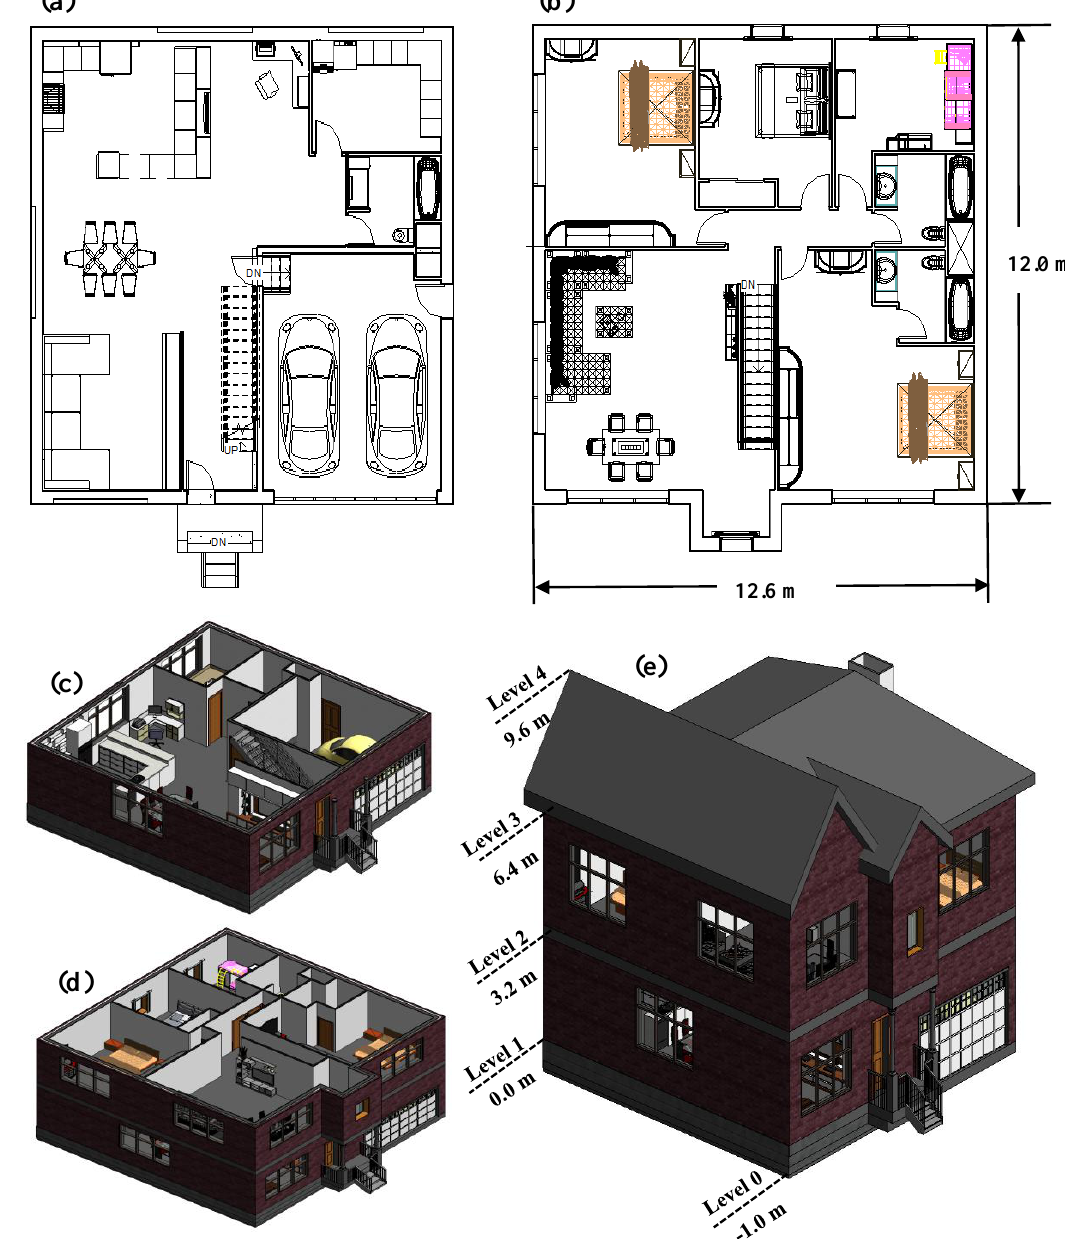
Figure A3. F3 archetype plans and sections: ( a ) First-story plan view; ( b ) Second-story plan view; ( c ) First-story 3-D view; ( d ) Second-story 3-D view; ( e ) Building 3-D view.